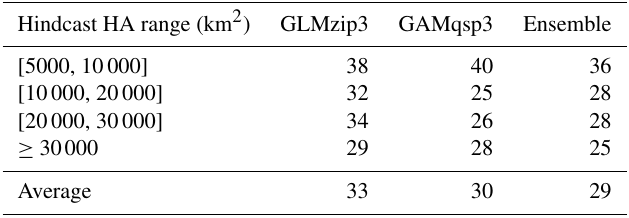
Table 2. Mean absolute percentage bias between predicted and hindcast HA in the test set within different ranges of hindcast HA. The mean bias when hindcast HA < 5000km 2 is not shown, since the prediction accuracy at high HA ranges is a more important feature of HA prediction models. The threshold of 5000km 2 is chosen because it is the goal HA set by the action plan (Mississippi River/Gulf of Mexico Watershed Nutrient Task Force, 2001, 2008). HA above this threshold is more worthy of attention.